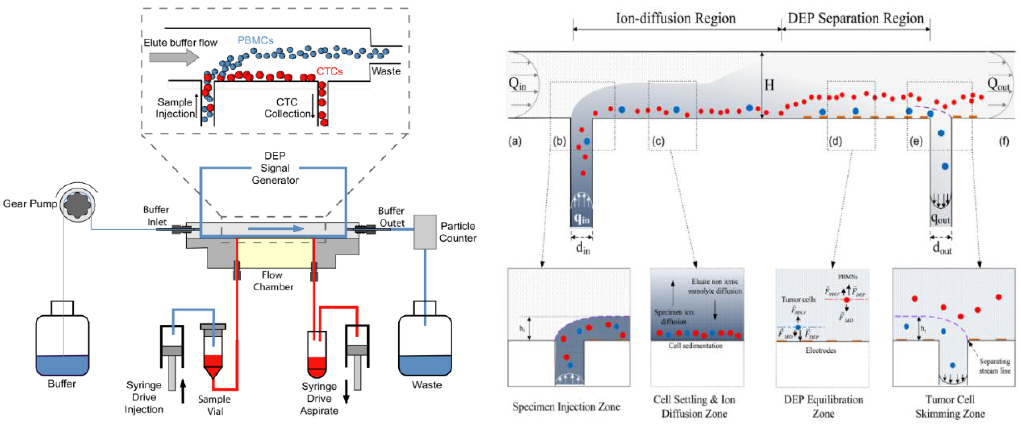
Figure 3. The vertical attraction (left) [34] and repulsion (right) [35,36] DEP.